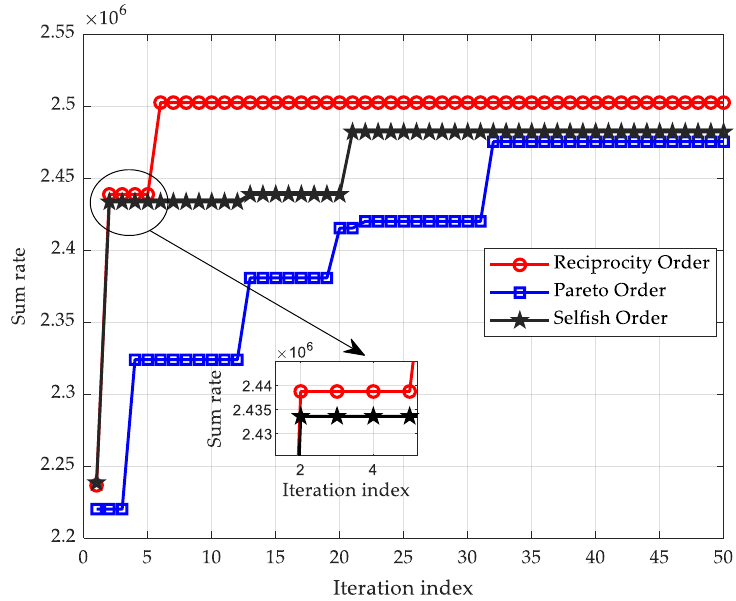
Figure 4. Schematic representation of the performance comparison of different coalition preference orders.